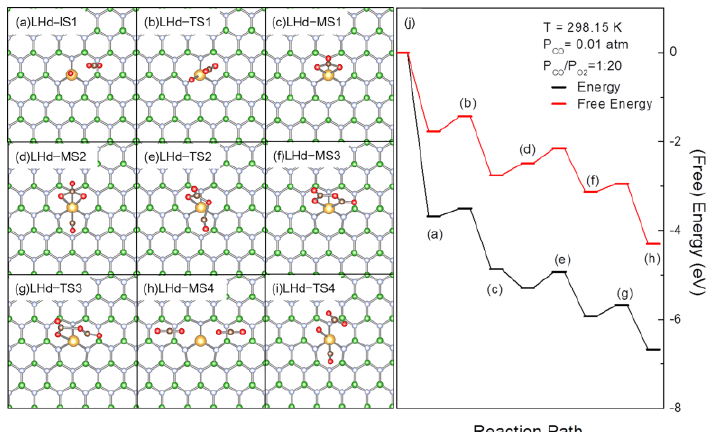
Figure 5. Optimized structures of the reaction species involved, including reaction intermediates, transition states and products ( a ) – ( i ), and (free) energy profiles ( j ) for CO oxidation over AuBN with the LHd pathway initiated with the coadsorption of CO with LH – MS1. In ( a ) – ( i ), the B, N, C and Au atoms are in green, light blue, brown and gold, respectively. In ( j ), the bracketed letters correspond to the structures shown in ( a ) – ( h ).